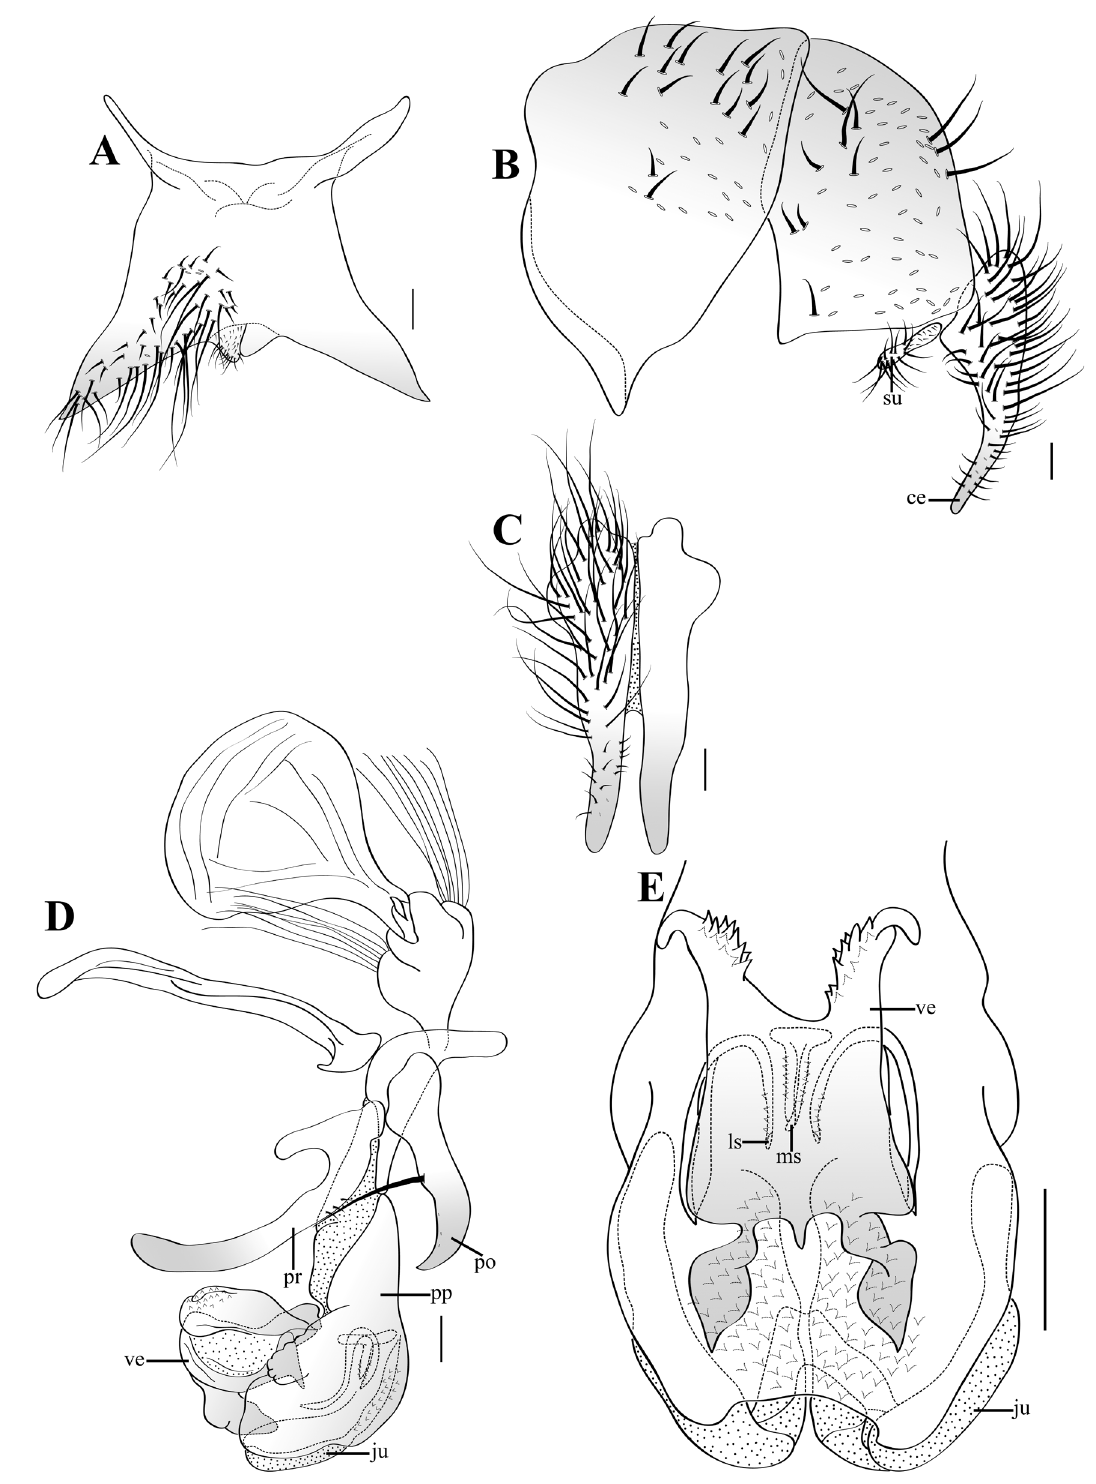
Fig. 7. Dexosarcophaga petra sp. nov., ♂, paratype (MNRJ [lost]), Brazil, Rio de Janeiro, Angra dos Reis. A . Sternite 5, ventral view. B . Syntergosternite 7 + 8, epandrium, cercus and surstylus, lateral view. C . Cerci, posterior view. D . Phallus and associated structures, lateral view. E . Distiphallus, ventral view. Abbreviations: see Material and methods. Scale bars = 0.1